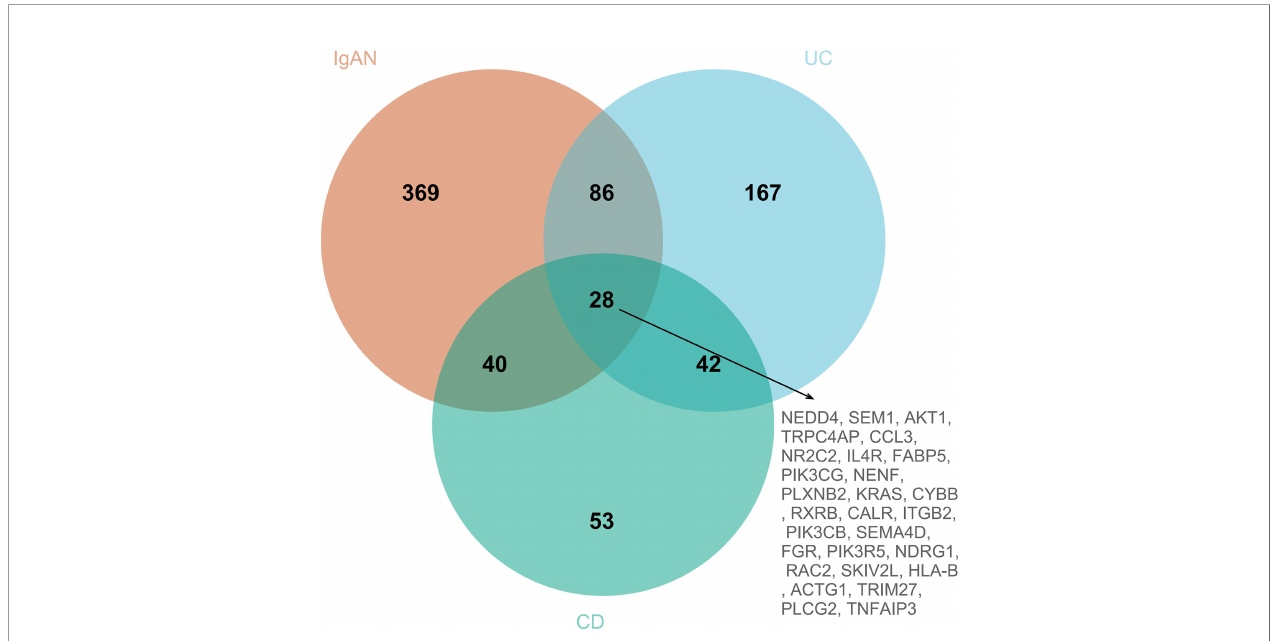
FIGURE 7 | The venn diagram of SIRGs, 28 SIRGs were identi fi ed form grey module in IgAN, turquoise and black modules in UC, and brown and green modules in CD.